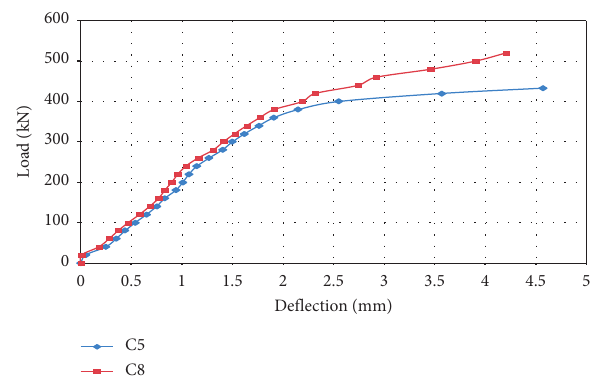
Figure 12: Load-deflection curve of corbels with concrete strength 45.8 and 45.6MPa and weight fractions of replacement aggregate 50% and a/d ratio 0.5 and